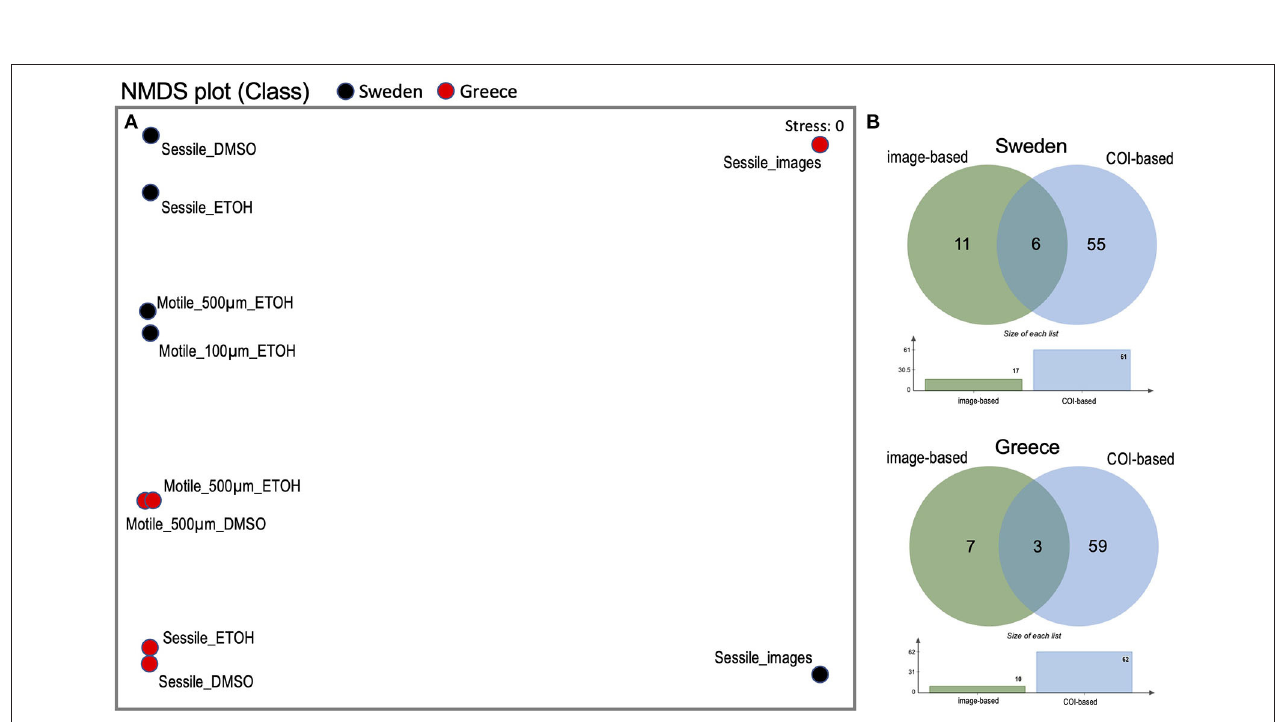
FIGURE 3 | Overview over variance and overlaps in composition of communities obtained from different fractions, preservations, as well as from plate images of two ARMS (Greece ARMS: Crete_1HERP_180928-190128, Sweden ARMS: Koster_VH2_180418-180906). (A) Non-metric Multi-dimensional Scaling (NMDS) plot at class level deducted from COI sequence and image analysis. (B) Venn diagram showing the overlap in the species identified from genetic data and images.